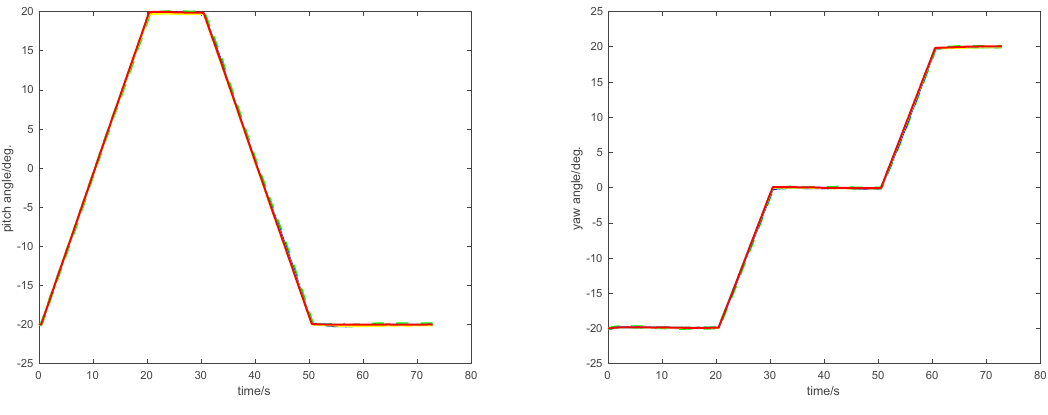
Figure 8. Motion trajectory of pitch axis and yaw axis.